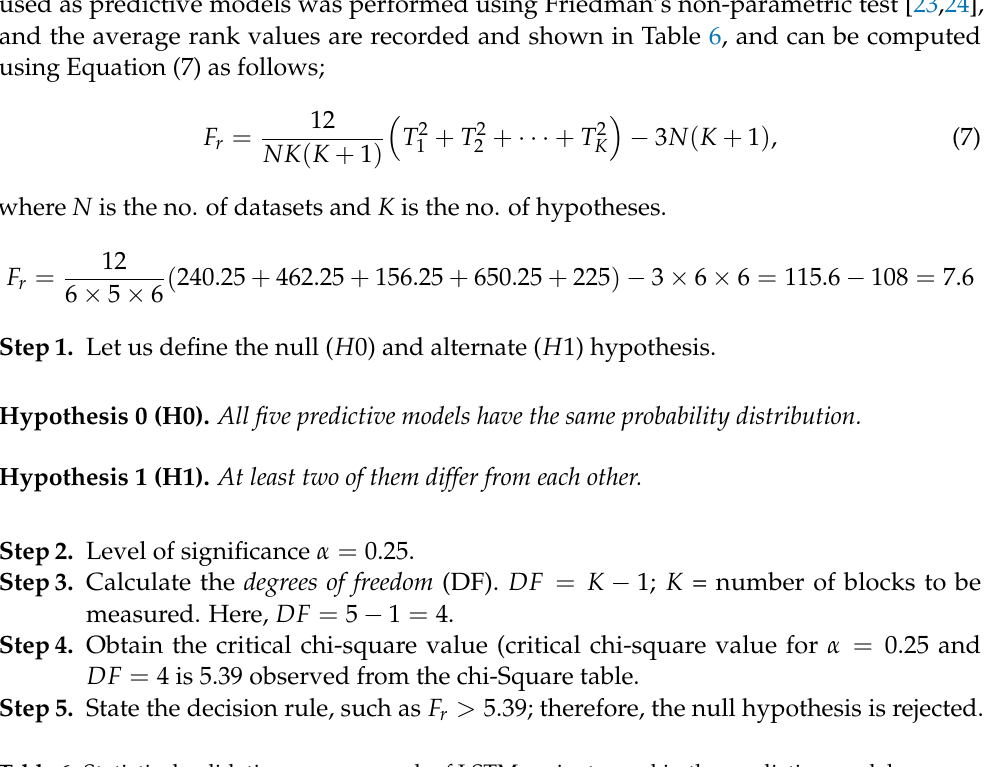
Table 6. Statistical validation: average rank of LSTM variants used in the predictive